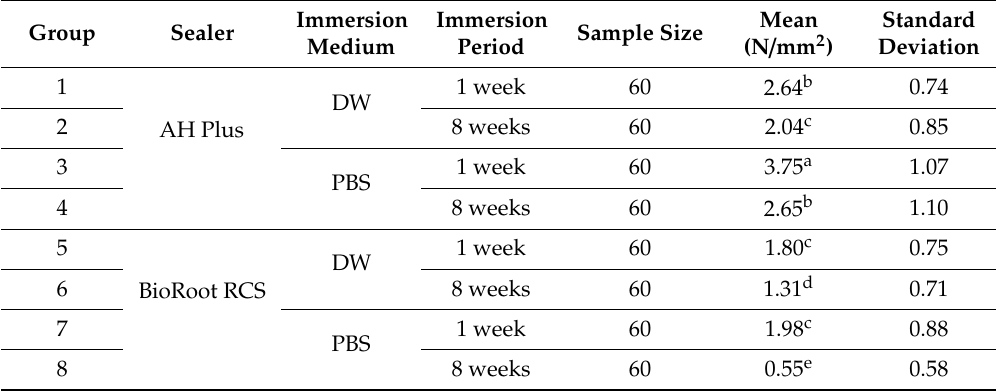
Table 1. Push-out bond strength values according to sealer, immersion medium, and immersion period (N/mm²).